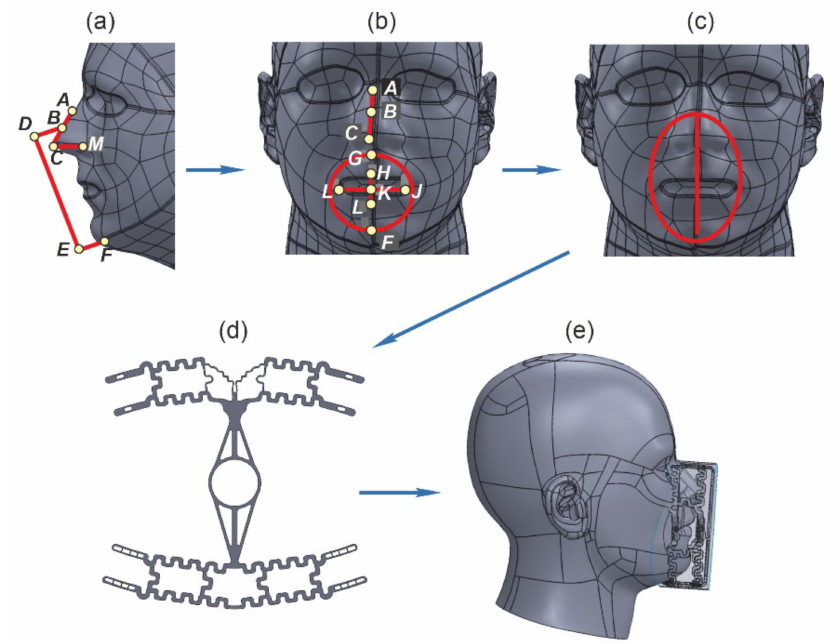
Figure 4. Stages of developing the structure of the FDR half mask frame: ( a ) general view of the head 3D-model; ( b ) contouring the frame; ( c ) frame sketch; ( d ) constructing the frame; ( e ) general view of the frame